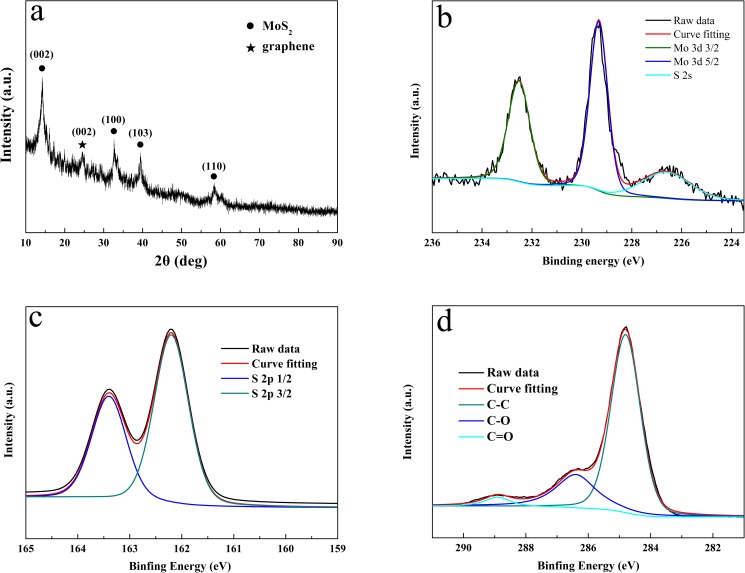
XRD pattern of MoS2 NSs/rGO hybrid (a). XPS images of Mo 3d (b) S 2p (c) and C (d).